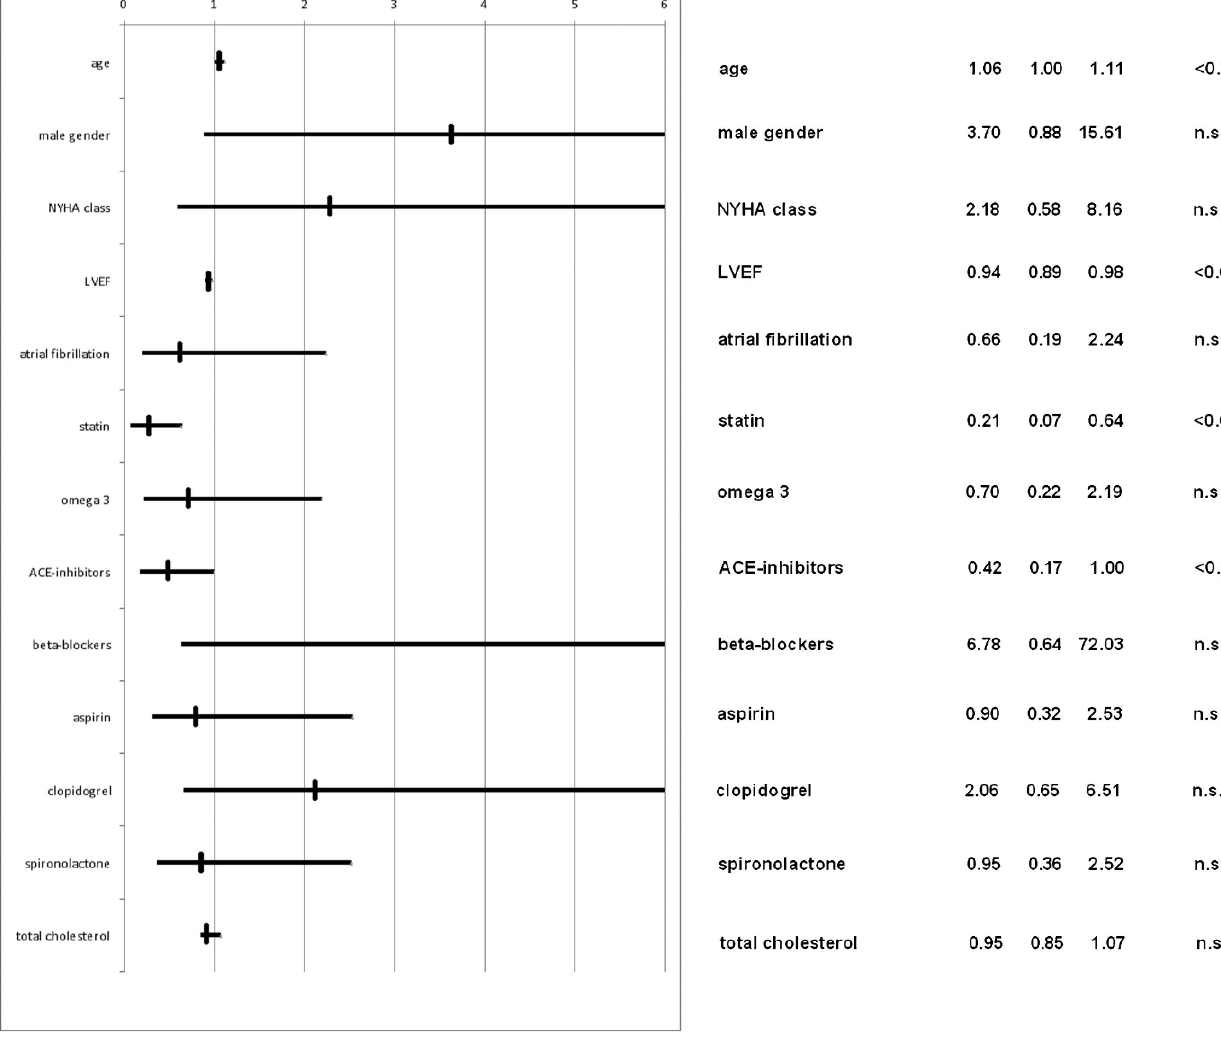
Figure 3 - After multivariate Cox regression analysis, higher readmission rates in subjects not receiving statins were independent of age, gender, LVEF, and concomitant therapy with ACE inhibitors and beta blockers (p